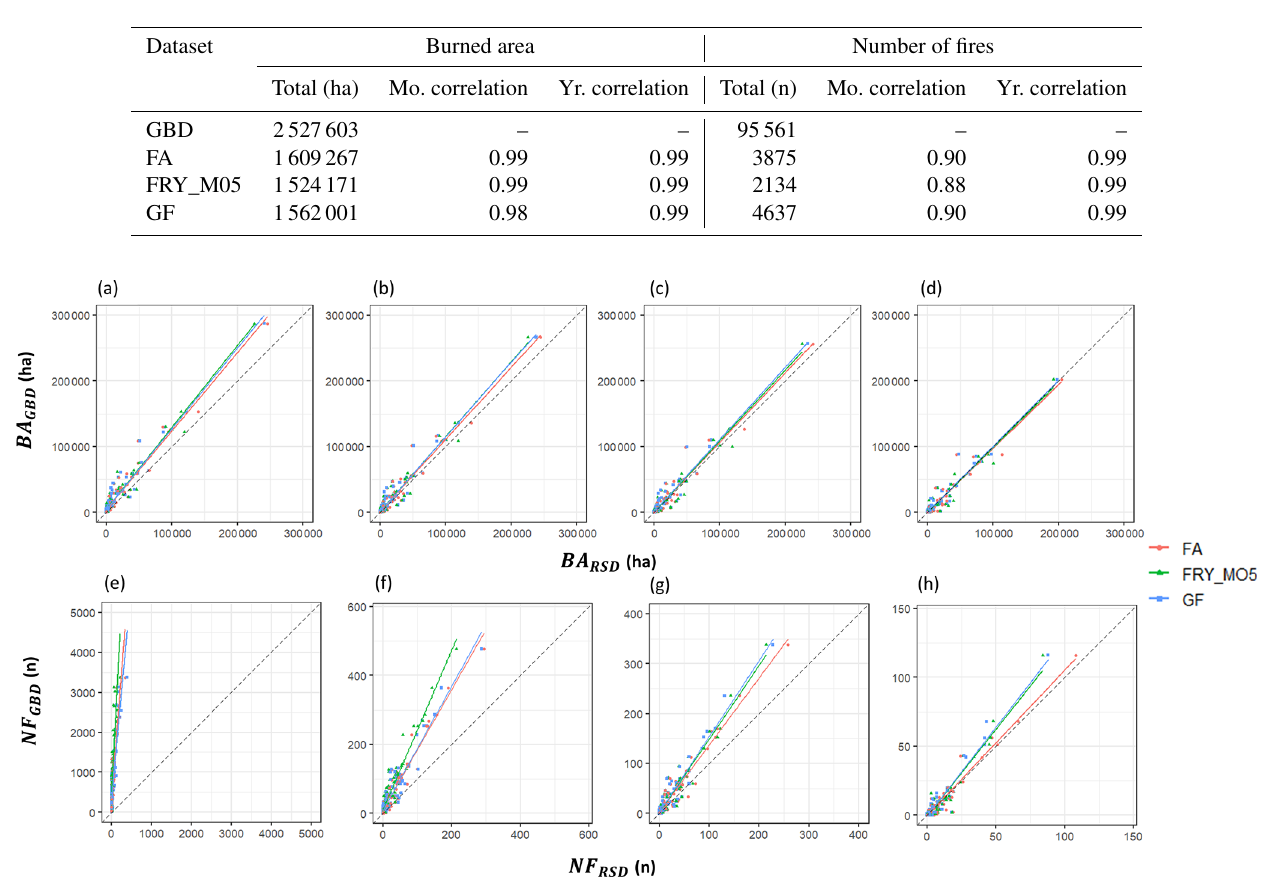
Figure 5. Comparison of the GBD and RSDs with respect to monthly burned area (a–d) and the number of fires (e–h) when considering (a) all fires ( > 1ha), (b) fires > 50ha, (c) fires > 100ha, and (d) fires > 500ha. (e–h) Same as (a–d) but for the number of fires. The 1 : 1 dashed lines represent the perfect fit between the